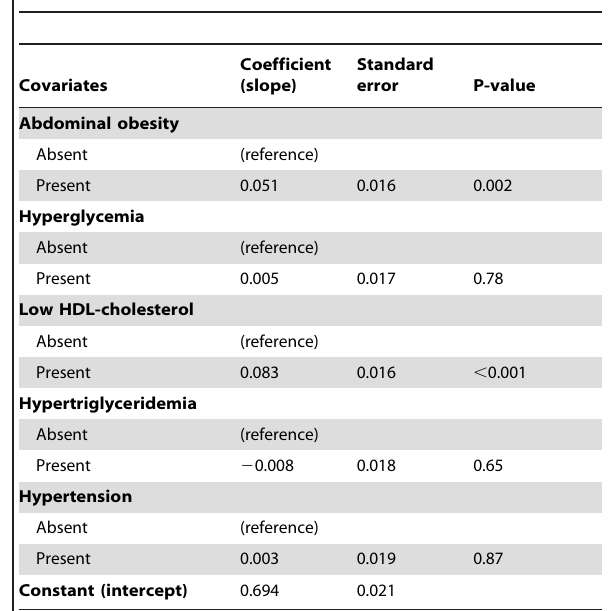
Table 3. Multivariate analysis of factors associated with serum lipopolysaccharide-binding protein (LBP) concentrations: metabolic syndrome components.